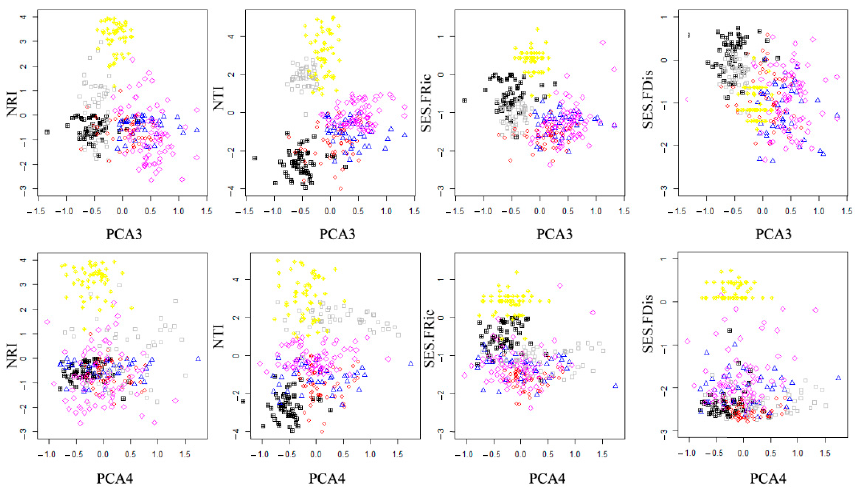
Figure A2. The relationships between functional and phylogenetic diversity and compound habitat gradients PC3 and PC4. Different color–marker combinations represent each forest plot. The abbreviations for each variable are listed in Table 1.